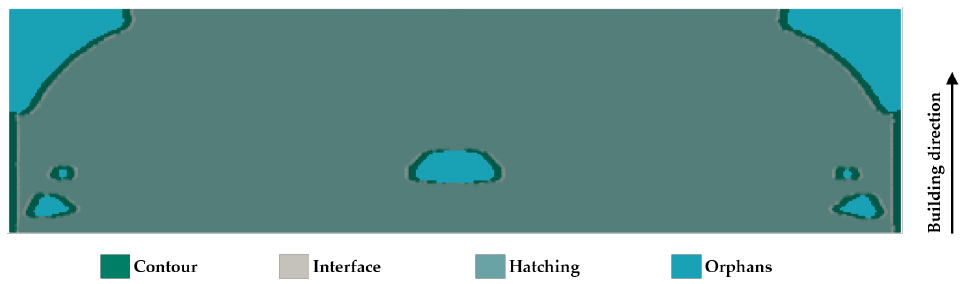
Figure 8. Initial FE mesh of the topology optimization, including the transferred material